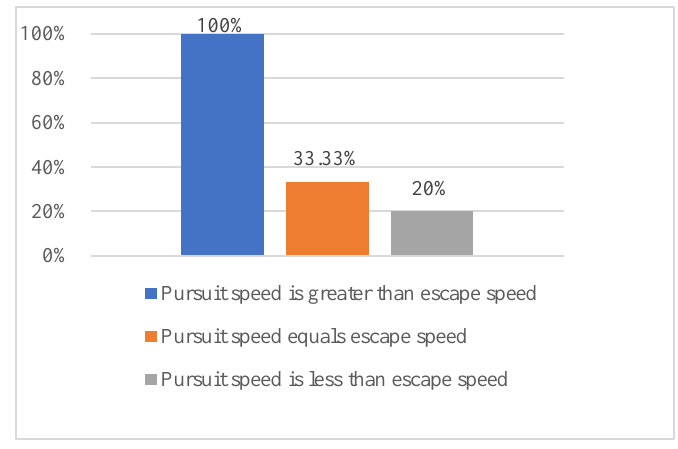
Figure 6. The success rate of pursuit tasks with different pursuit speeds. During the repeated game pursuit simulation experiment, the pursuit processes of the pursuit robots with different speeds were selected to be shown in Figure 7.